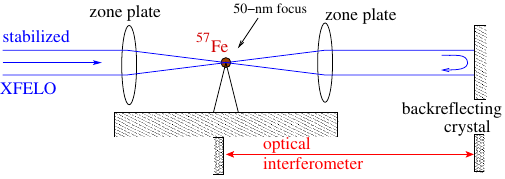
FIG. 5. Schematic depiction of how to probe a meter-to- kilometer-long x-ray standing-wave field while comparing to an optical length standard. Two Fresnel zone plates generate a 50-nm x-ray focus that travels along the standing waves. A single 57 Fe nucleus in the focus senses the standing-wave intensity through resonance fluorescence.